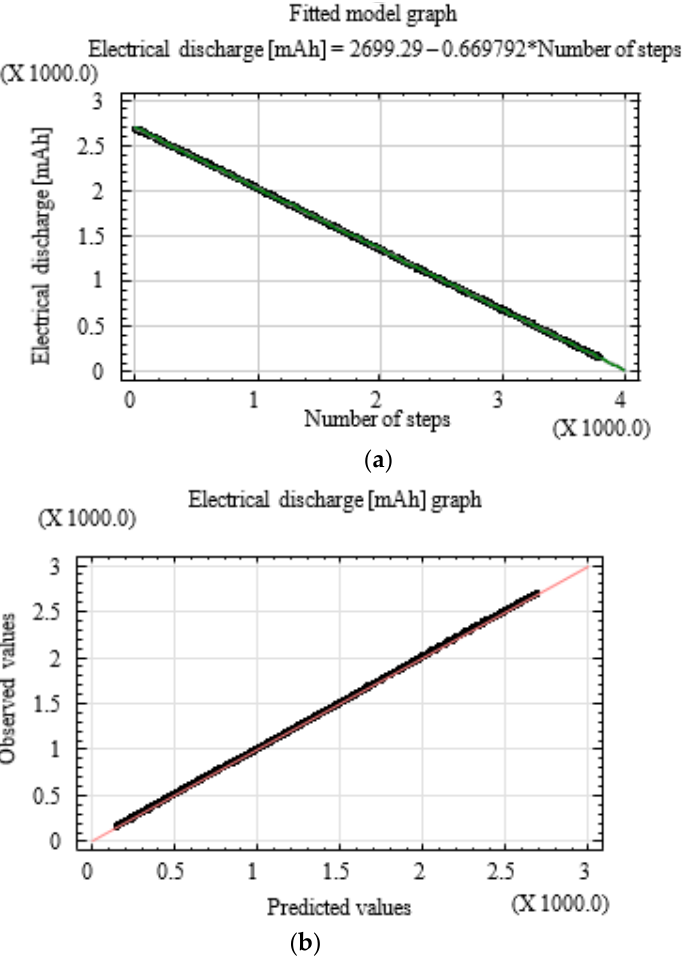
Figure 10. Model lineal graphs. ( a ) Graph of fitted model; ( b ) Graph of Predicted values Vs. Observed values.